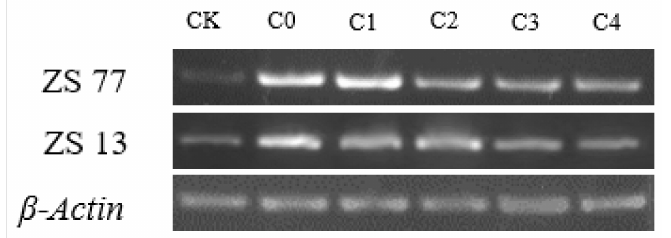
Figure 9. Semi-quantitative RT-PCR of NCED3-like gene. RNA was isolated from the leaves of normal irrigated (CK) and drought treated sweet potato plants foliar spraying 0 (C0), 1.00 (C1), 2.00 (C2), 4.00 (C3), and 8.00 mg · L − 1 (C4) SA solution after 24 h treatment. Actin was used as an internal control. The experiment was repeated twice with the similar results.